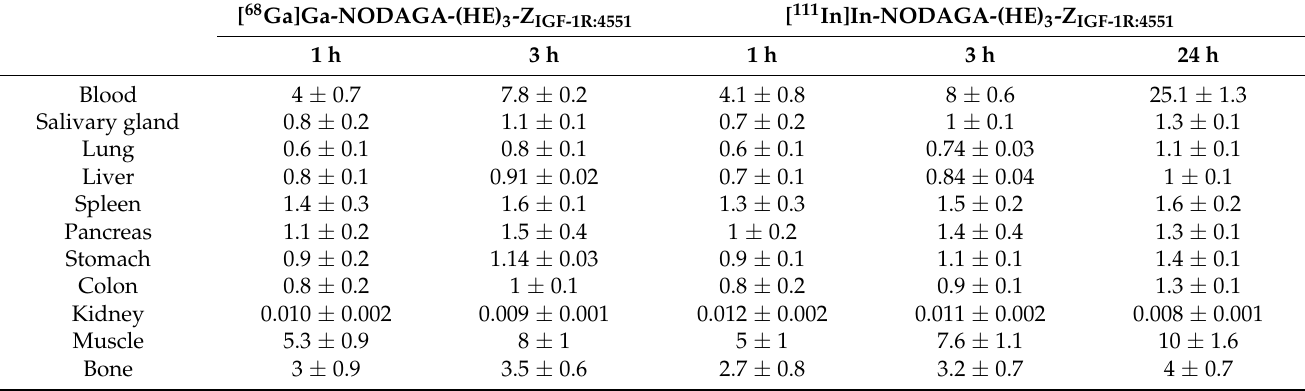
Table 3. Tumor-to-organ ratios for [ 68 Ga]Ga-NODAGA-(HE) 3 -Z IGF-1R:4551 and [ 111 In]In-NODAGA- (HE) 3 -Z IGF-1R:4551 in BALB/C nu / nu mice bearing DU145